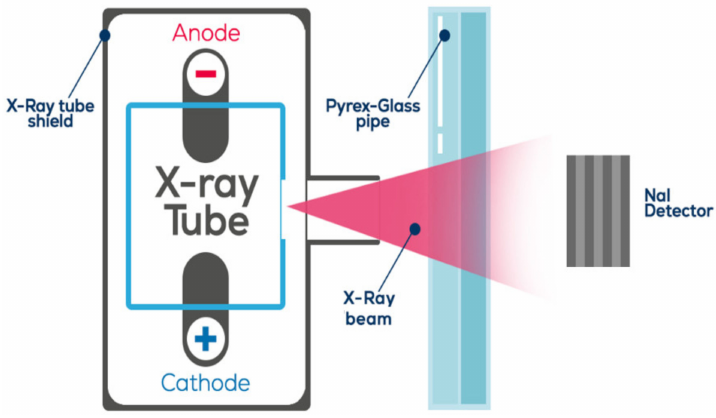
Figure 2. Modeled detection system using the MCNP code.